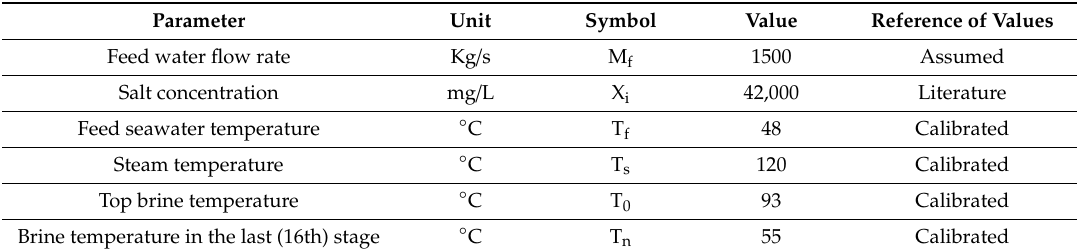
Table 6. Technical parameters used in the